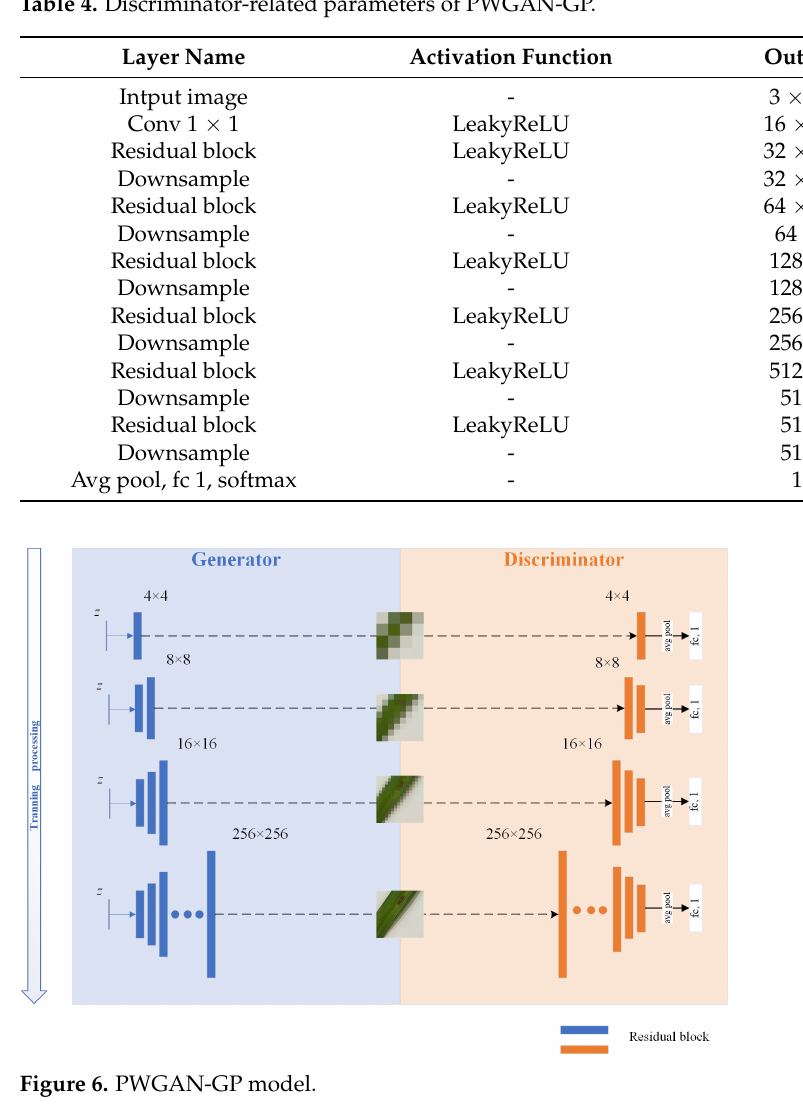
Table 4. Discriminator-related parameters of PWGAN-GP.